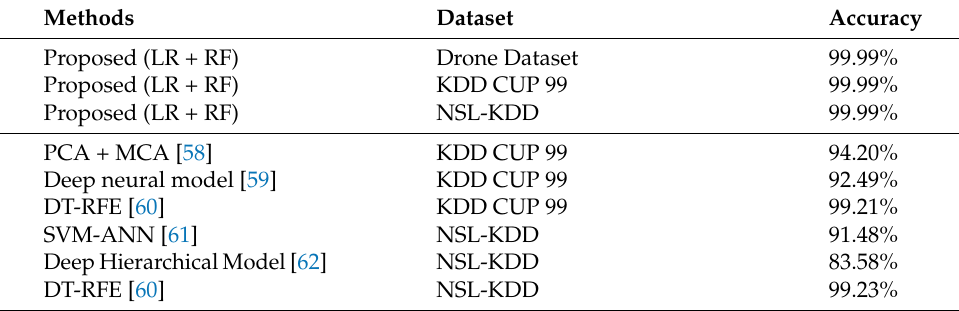
Table 6. Performance comparison of proposed model with state-of-the-art